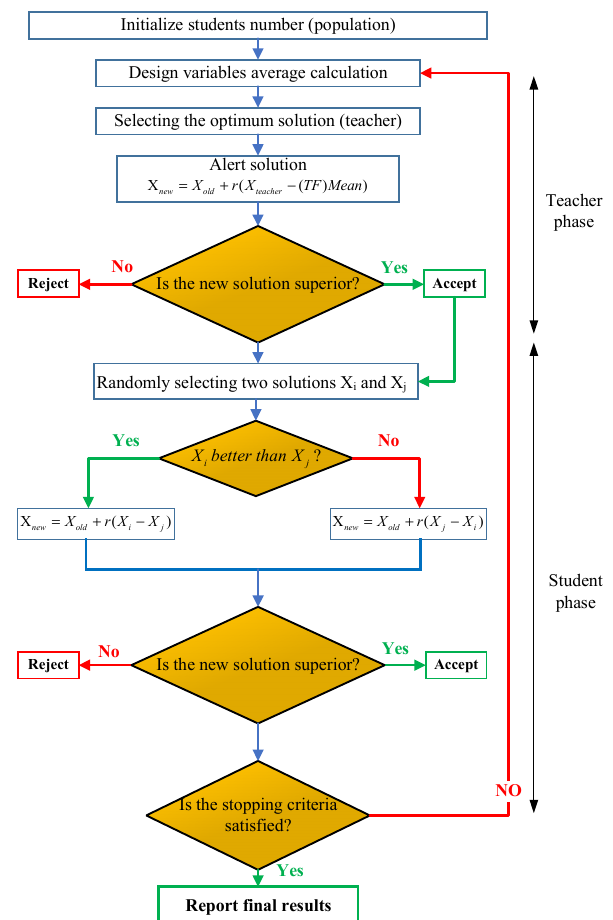
Figure 5. A schematic diagram of the teaching learning-based optimization algorithm (TLBO)